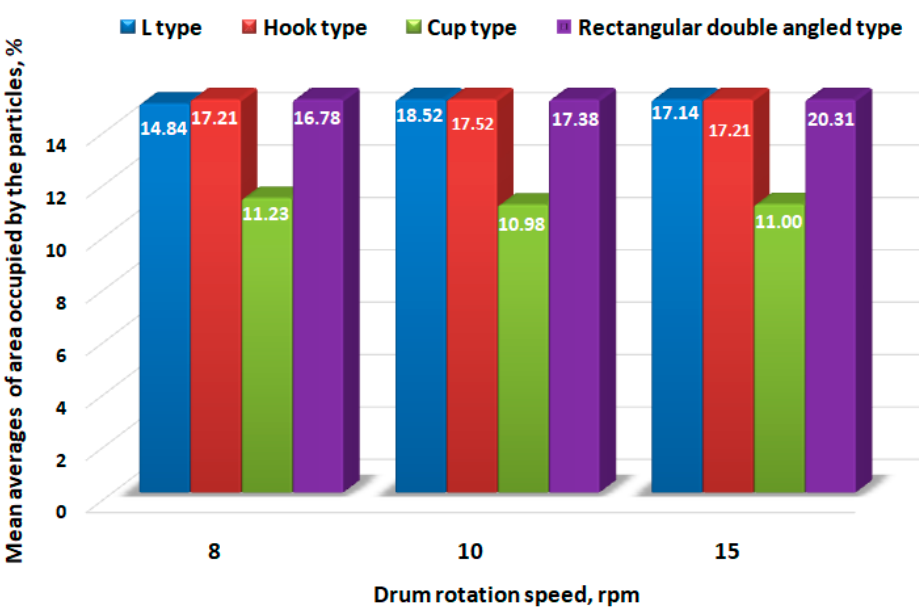
Figure 9. The influence of flight shape on the dispersion degree of the particle for different drum rotation speeds.